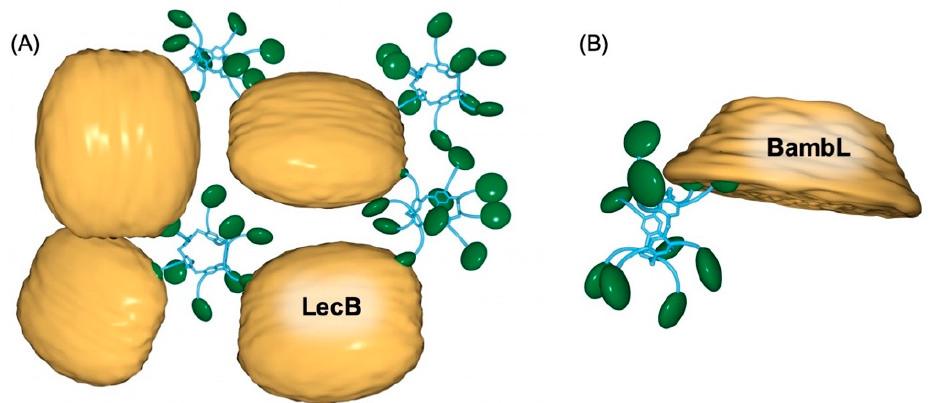
Figure 6. ( A ) Schematic representation of the clustering resulting from the association of a decavalent glycopillar[5]arene derivative with Lec A. ( B ) Schematic representation of the simultaneous binding of two fucose units of a decavalent glycopillar[5]arene derivative to BambL.